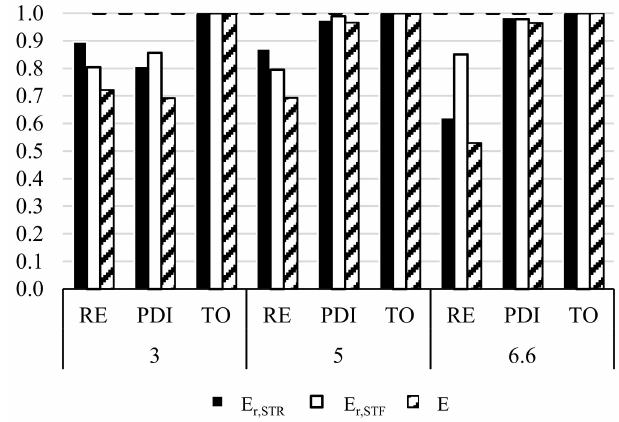
Figure 17. Efficiency assessment of the analysed